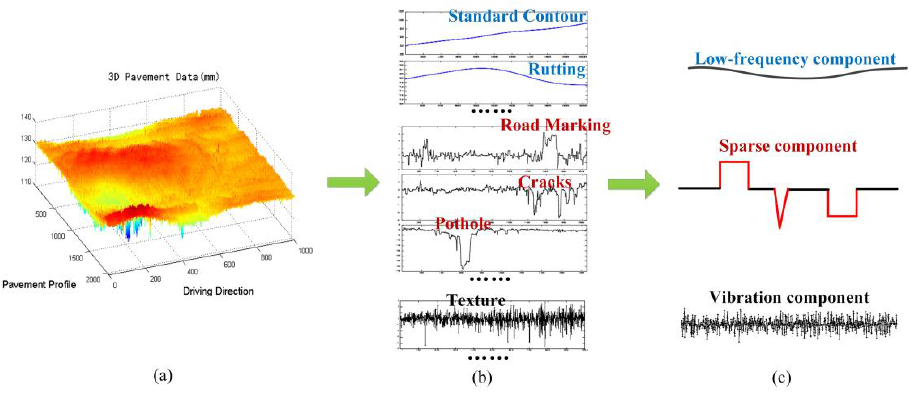
Figure 5. 3D pavement data and some typical components, ( a ) 3D pavement data; ( b ) typical pavement distresses and performance indicators from a perspective of ideal profile; and ( c ) some typical components, low-frequency components, sparse components, and vibration